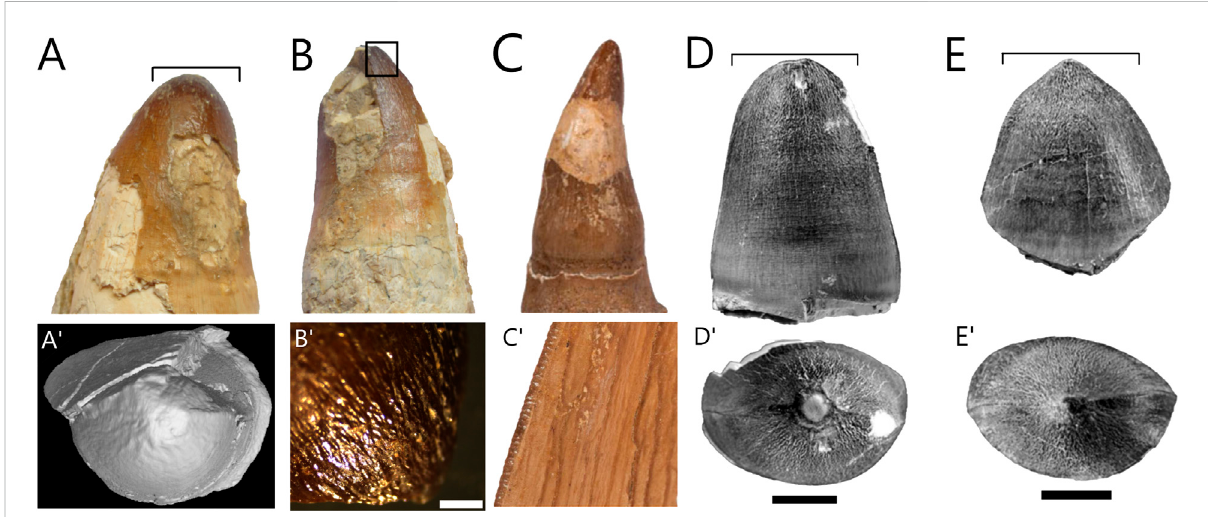
FIGURE 7 Micro-CT scans of fragmentary, isolated teeth, from cf. Prognathodon muzzle unit (CGP/1/2265). (A) Isolated tooth 1 (IT-1) in labial view. (A 9 ) Three-dimensionalmicro-CTscanimageofIT-1inocclusalviewwithbluntapexandanastomosingridgesvisible. (B) Isolatedtooth2(IT-2)inlingual view with box frame giving locational information for B ’ . (B 9 ) High magni fi cation image of anastomosing ridges at apical region of IT-2 using dissecting microscope. (C) Photograph of CCMGE 818 P. lutugini tooth crown in lingual view adapted from Gregoriev (2013). (C 9 ) High magni fi cation image of fi ne serrations on carinae of P. lutugini adapted from Gregoriev (2013). (D) Photograph of OCP. DEK/GE 349 “ P. currii ” tooth crowninlabialorlingualviewadaptedfromBardetetal.(2005). (D 9 ) PhotographofOCP.DEK/GE349 “ P.currii ” toothcrowninocclusalviewadapted from Bardet et al. (2005). (E) Photographs of OCP. DEK/GE 350 “ P. currii ” tooth in labial or lingual view adapted from Bardet et al. (2005). (E 9 ) Photographs of OCP. DEK/GE 350 “ P. currii ” tooth in occlusal view adapted from Bardet et al. (2005). Scale bars: (A,A 9 ,B,C,C 9 ) = not to scale; B ’ = 2 mm; (D,D 9 ,E,E 9 ) = 10